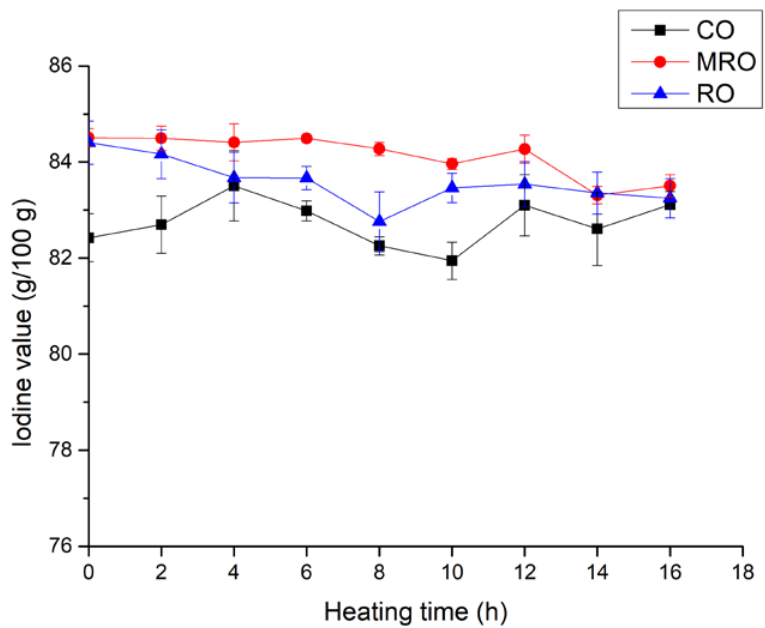
Figure 2. Changes in iodine value of three kinds of camellia oil during heating.